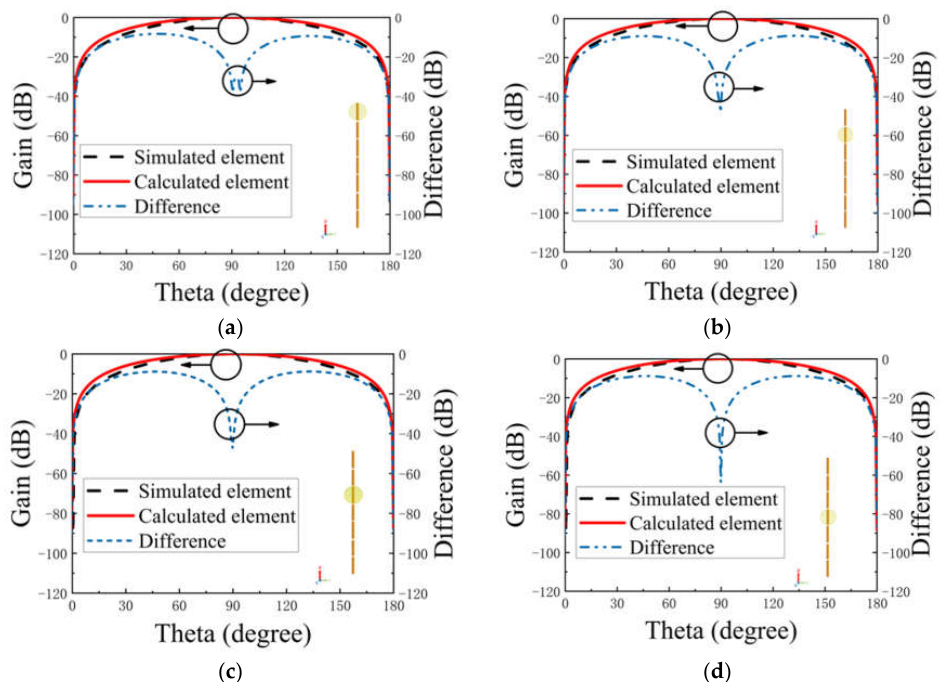
Figure 3. Extraction results of the radiation field of 1–4 elements on the phi = 0° surface. ( a ) Element 1, ( b ) element 2, ( c ) element 3 and ( d ) element 4.